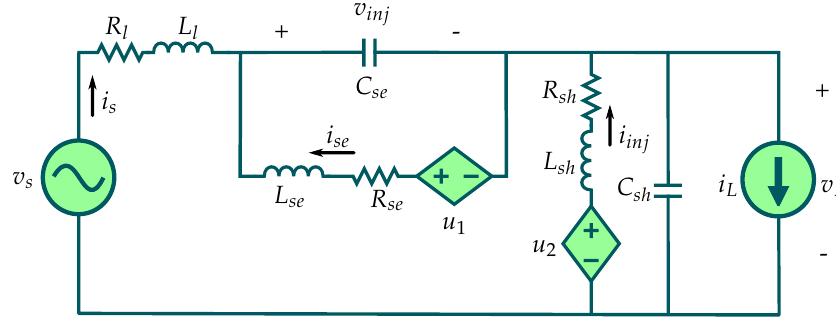
Figure 2. Equivalent model of a single-phase grid-tied